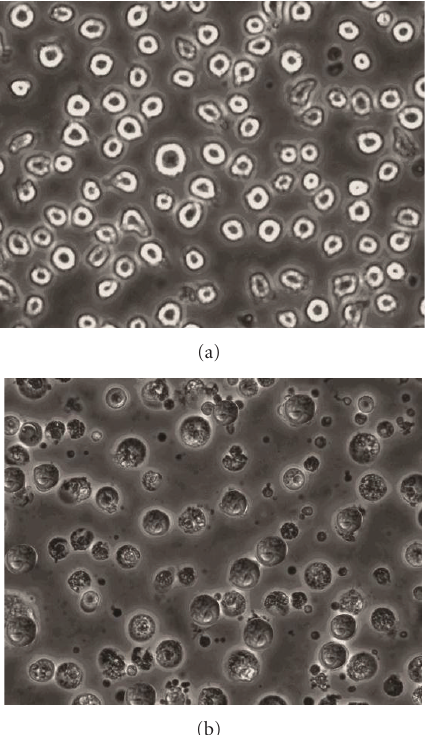
Figure 5: Morphological changes in HL60 cells (a) control cells with intact nuclei; (b) cell membrane blebbing, nuclear frag- mentation, and chromatin condensation in presence of [Ni(1,10- phen)(EMIIMP)(H 2 O) 2 ]Cl.